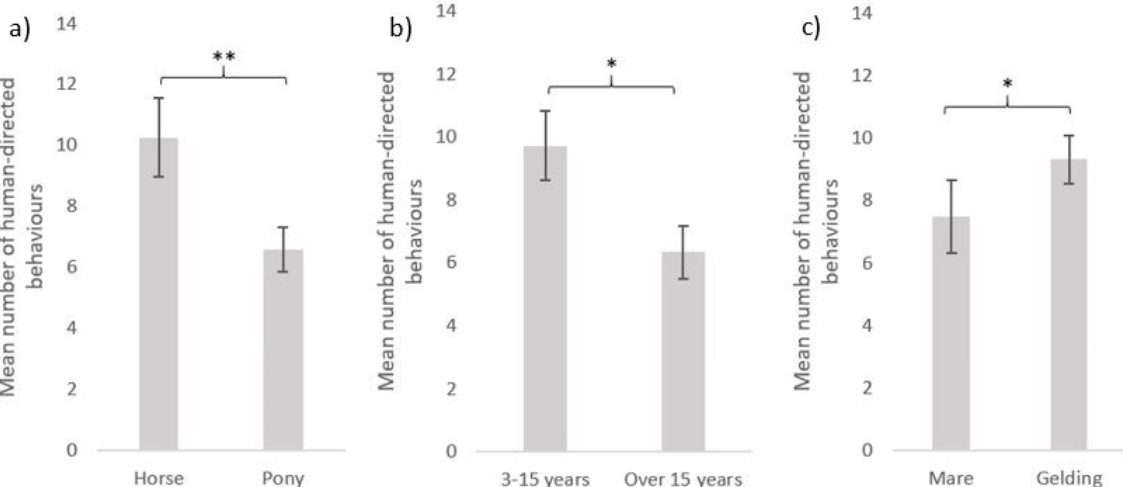
Figure 5. Human-directed behaviours (mean ± SE) during the motionless person test according to equids’ characteristics: ( a ) equine type (horses: N = 81, ponies: N = 91); ( b ) age (3–15 years old: N = 101, over 15 years old: N = 71); ( c ) sex (mare: N = 93, gelding: N = 79). GLM negative binomial. **: p < 0.01, *: p <